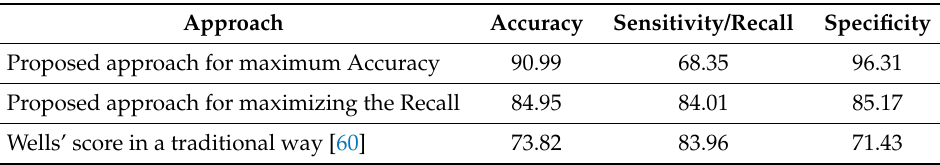
Table 9. Comparison versus Wells’ criteria in a traditional